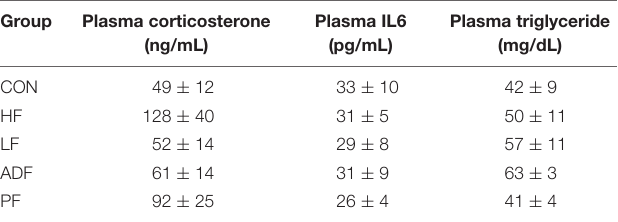
TABLE 1 | Experimental values of plasma corticosterone, IL6, and triglycerides. Group Plasma corticosterone Plasma IL6 Plasma triglyceride (ng/mL) (pg/mL) (mg/dL) CON 49 ± 12 33 ± 10 42 ± 9 HF 128 ± 40 31 ± 5 50 ± 11 LF 52 ± 14 29 ± 8 57 ± 11 ADF 61 ± 14 31 ±